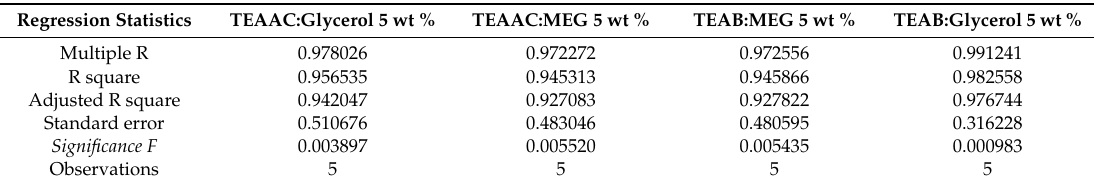
Table 4. Statistical analysis of experimental HLVE data.